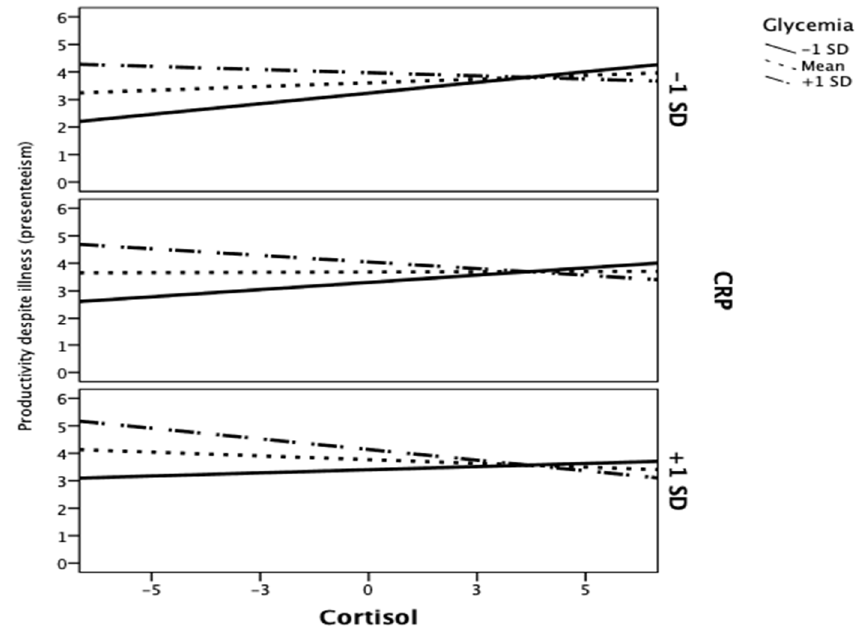
Figure 2. Interaction of Cortisol and CRP and Cortisol and Glycemia levels predicting productivity despite illness (presenteeism).